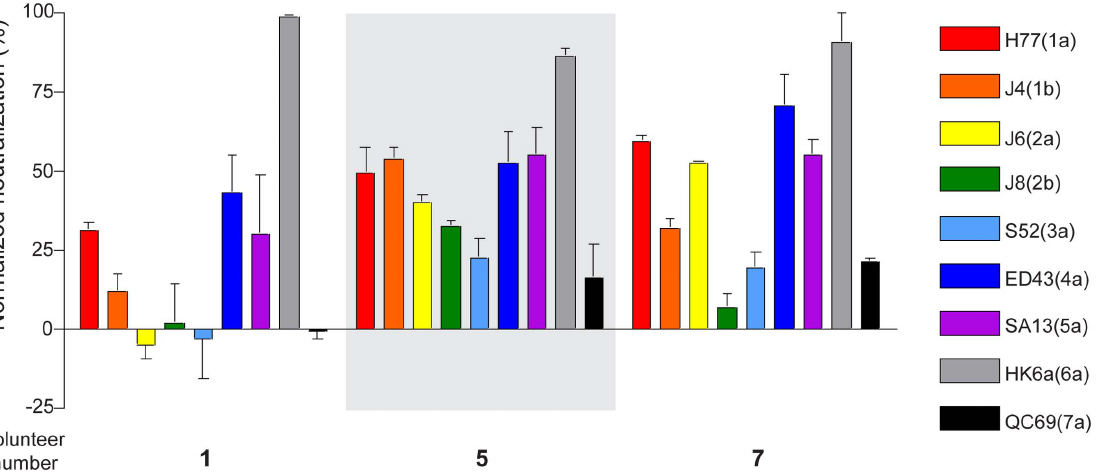
Figure 2. Human antisera cross-neutralizes all 7 major HCV genotypes. Sera of volunteers 1, 5 and 7 were tested for neutralization activity against chimeric 1a (H77C), 1b (J4), 2a (J6), 2b (J8), 3a (S52), 4a (ED43), 5a (SA13), 6a (HK6a) or 7a (QC69) HCVcc [3]. Virus neutralization assays were performed using pre- and post- vaccination sera at a concentration of 1 in 50. Levels of neutralization activity of post-vaccination sera were normalized with the activity of pre-vaccination sera. Representative of two independent experiments performed in triplicate are shown.